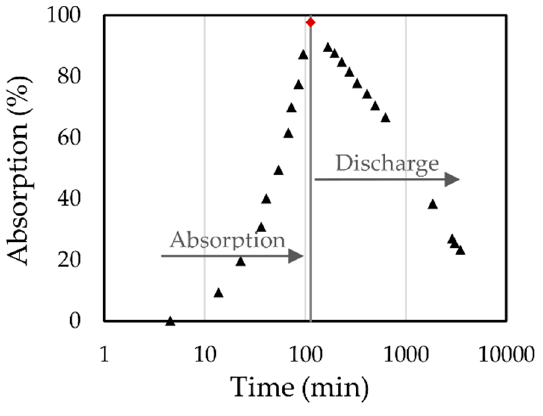
Figure 5. Absorption test results of polyimide foam.